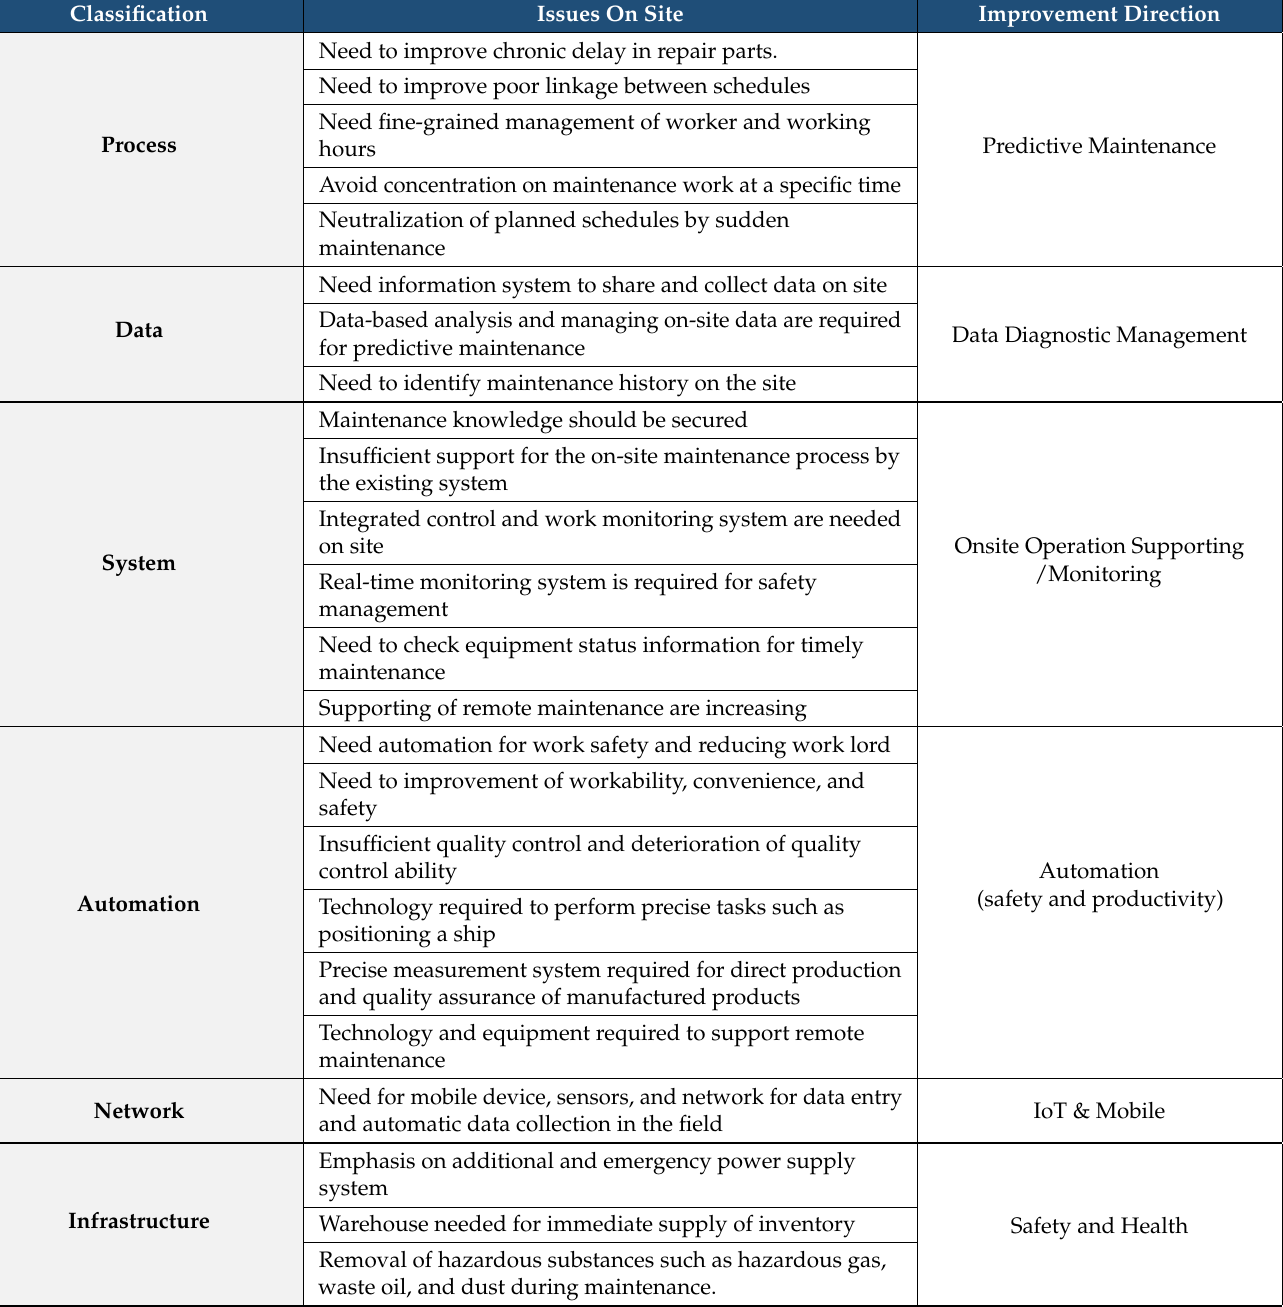
Table 1. Issues to be transformed in the vessel maintenance